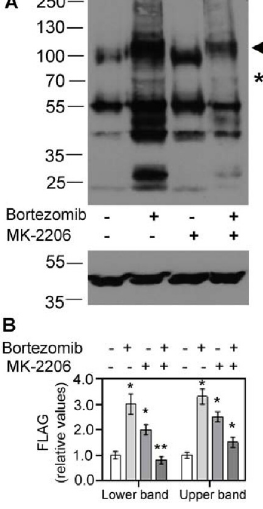
Figure 2. Effect of proteasomal degradation on SLC6A14. HEK293 cells were transfected for 24 h with p3xFLAG-CMV14/B 0,+ . Where indicated with “+” sign, 50 nM bortezomib was given for 24 h, while 5 µ M MK-2206 was added for the last 30 min, “ − ” means lack of the specified compound. ( A ) The upper panel shows the detection of SLC6A14 with anti-FLAG antibodies, while lower panel shows the detection of β -actin. The arrow indicates the fully glycosylated protein, the asterisk shows the core glycosylated species. ( B ) Integration of blots with FLAG detection. The analysis was performed with cells from 2 independent passages, and repeated for 2 different lysates from each passage. Significance of the respective control of the lower and upper bands: * p < 0.01, ** p < 0.05.